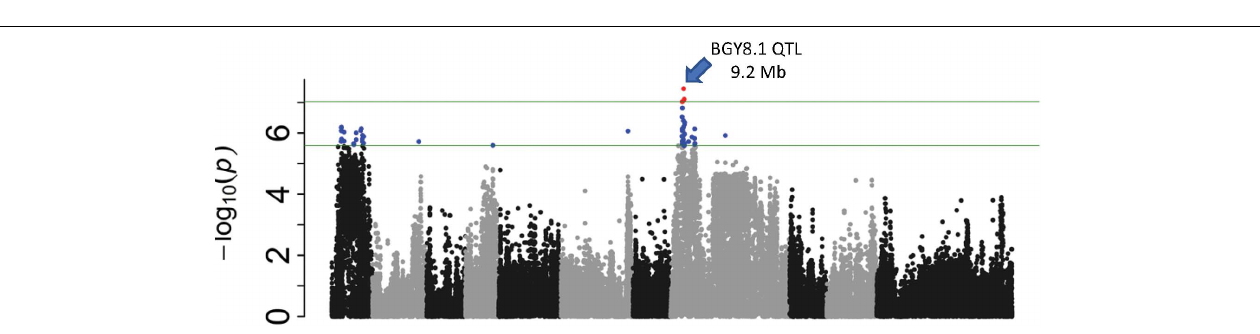
FIGURE 8 | Manhattan plot for a subpopulation of 128 lines from the CIAT population with bgm-1 (PvNAC1 gene marker) used for detection of QTL (BGY8.1) needing bgm-1 for expression.